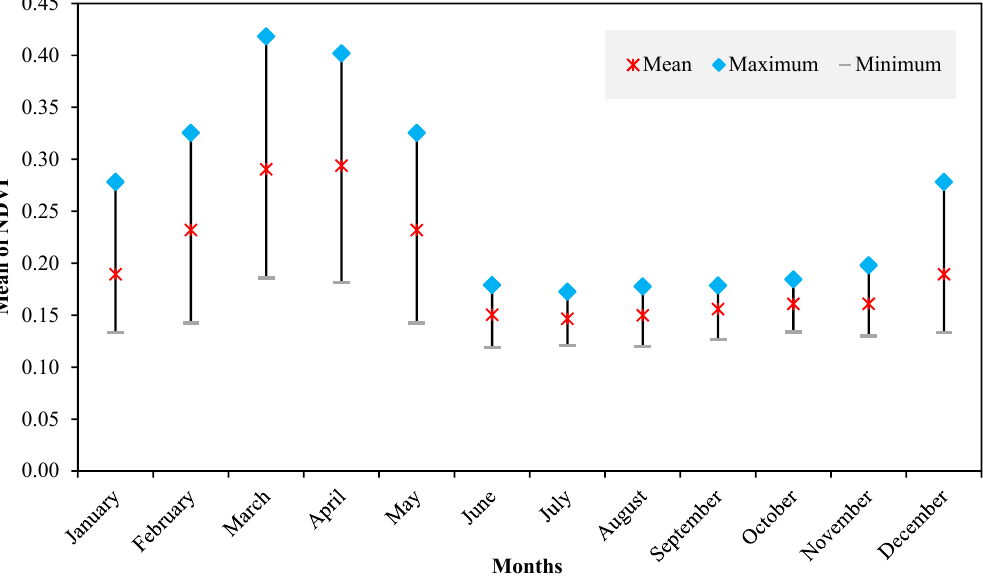
Figure 4. The NDVI mean for the study area obtained from MODIS products (MOD13C3) with 5000 m spatial resolution.